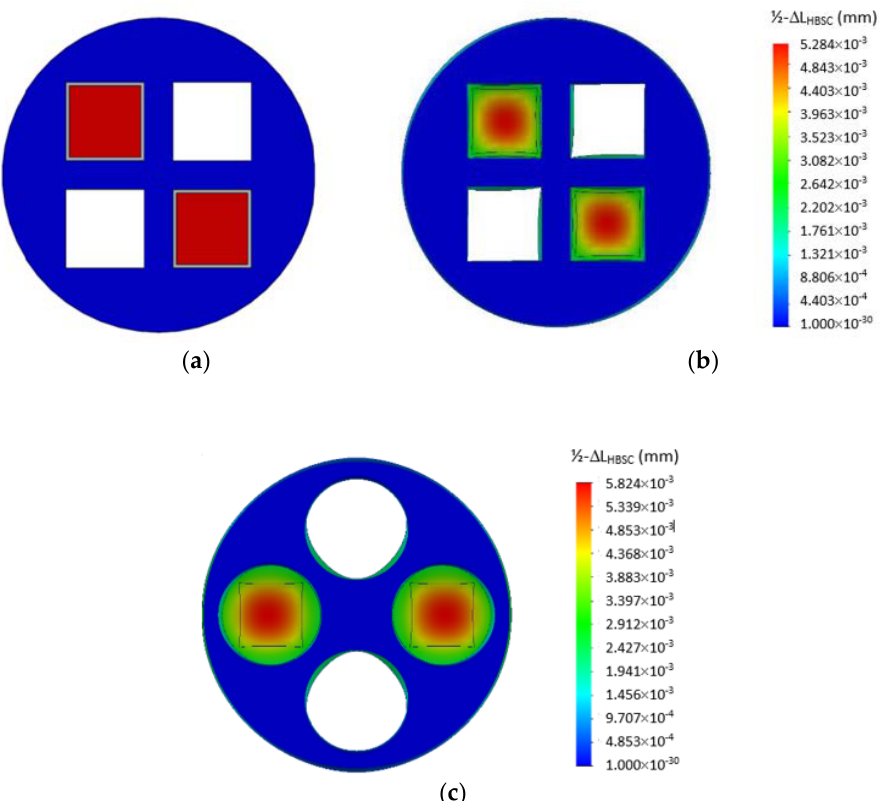
Figure 3. ( a ) Top view of a cut (2 + 2)-HBSC showing the reference mid plane (in blue) and the load bearing surfaces (in red) at the base of individual recesses; and, ( b ) simulation result under 150 kg axial load for (2 + 2)-HBSC with square cross-sectioned recesses of 5.5 × 5.5 mm 2 bore dimensions and 2.5 mm base thickness, and ( c ) for (2 + 2)-HBSC with circular cross-sectioned recesses of 7.5 mm bore diameter and 3 mm base thickness. The color scheme gives the contours of axial (z-) displacement at the top face of respective recess bases.